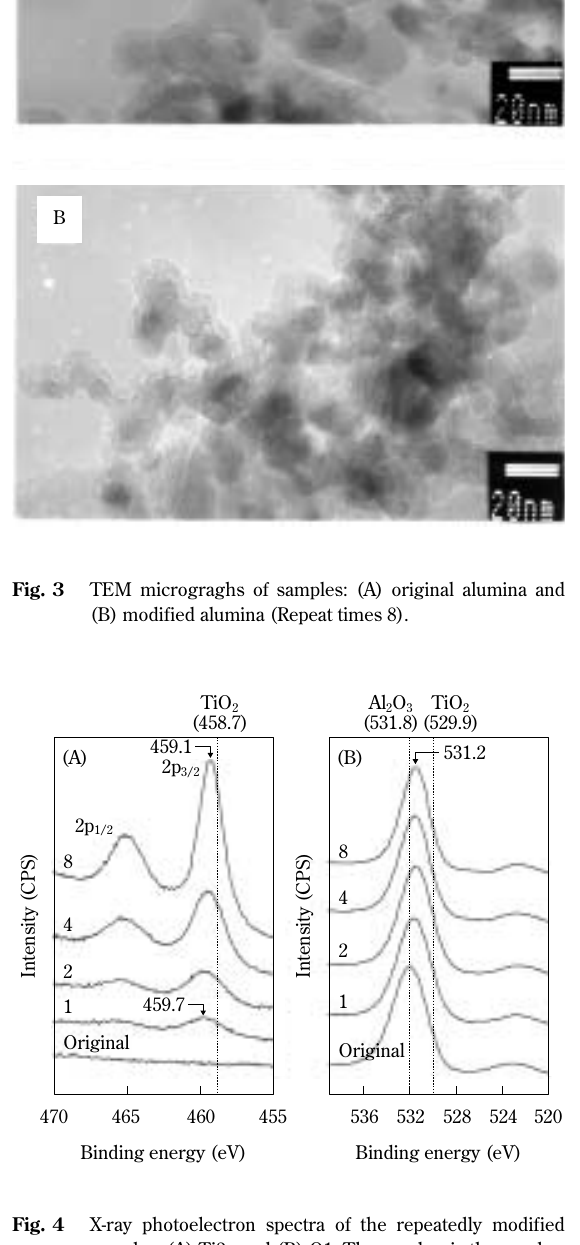
Fig. 4 X-ray photoelectron spectra of the repeatedly modified samples: (A) Ti2p and (B) O1. The number is the number of repetitions.